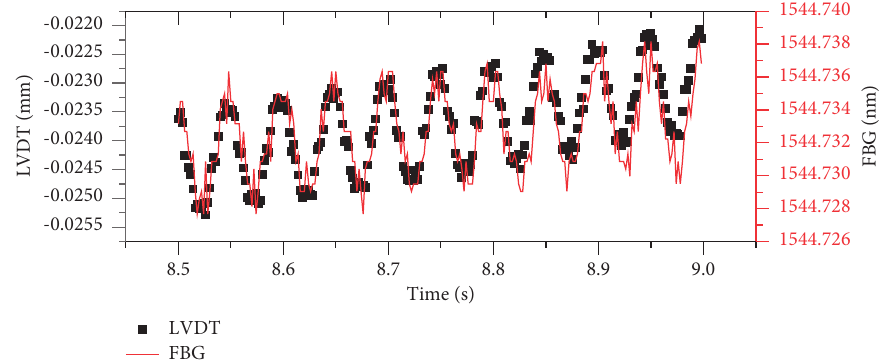
Figure 5: Signal comparison for the LVDTs and the FBG sensor.